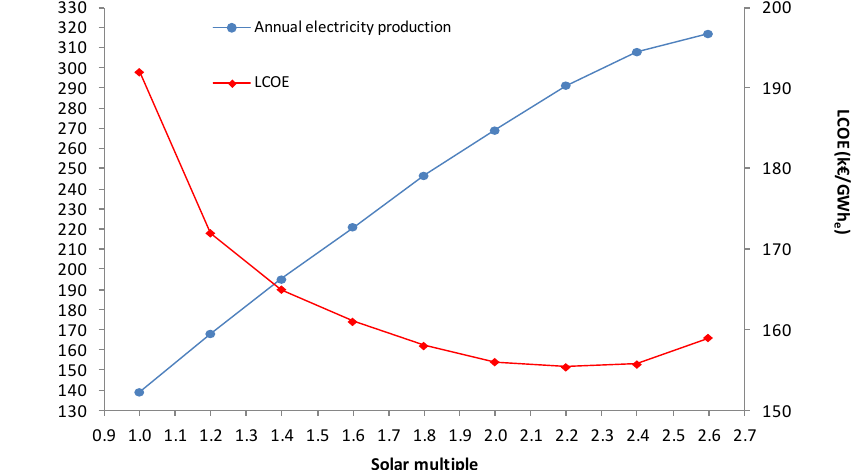
Figure 11. Annual net electricity generation and LCOE as SM function for Area 3, Death Valley, CA.